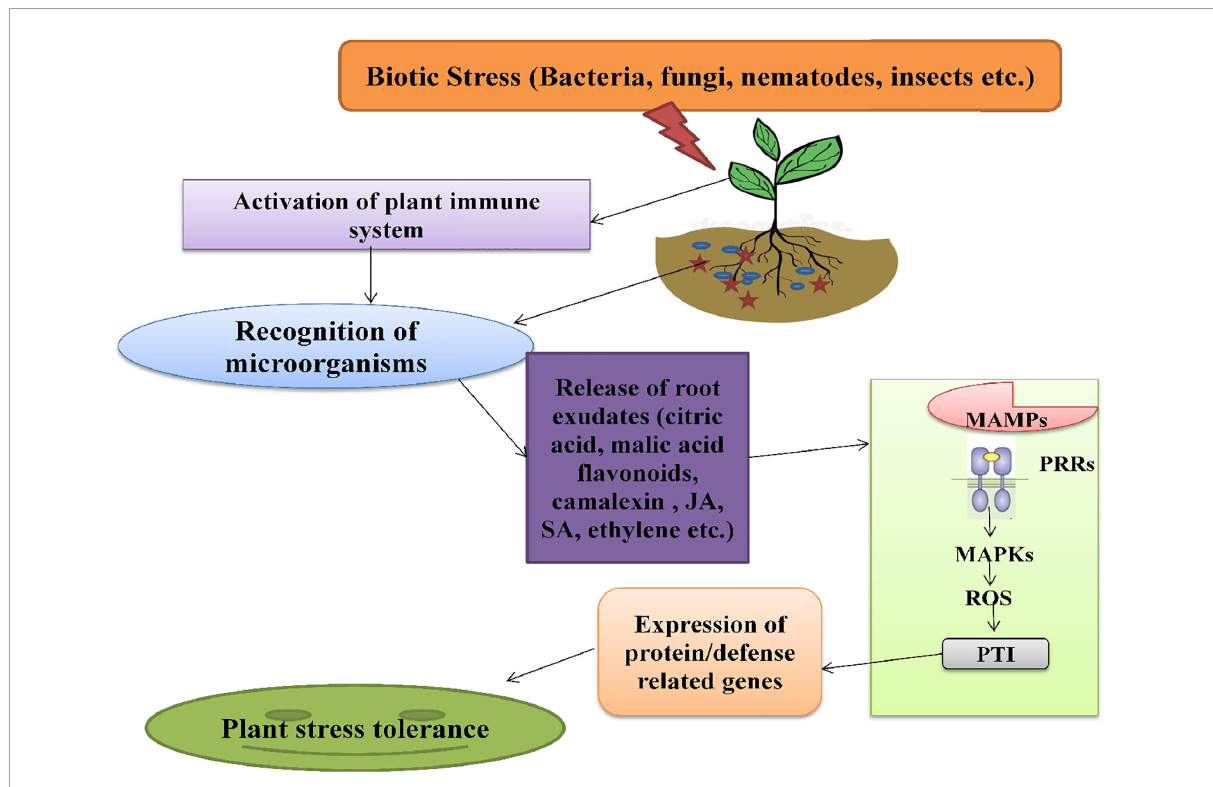
FIGURE4 The mechanism of action of phytomicrobiome on plant immune system under biotic stress. MAMPs, microbe-associated molecular patterns; PRRs, pattern-recognition receptor; MAPKs, mitogen-activated protein kinases; ROS, reactive oxygen species; PTI, pattern-triggered immunity.